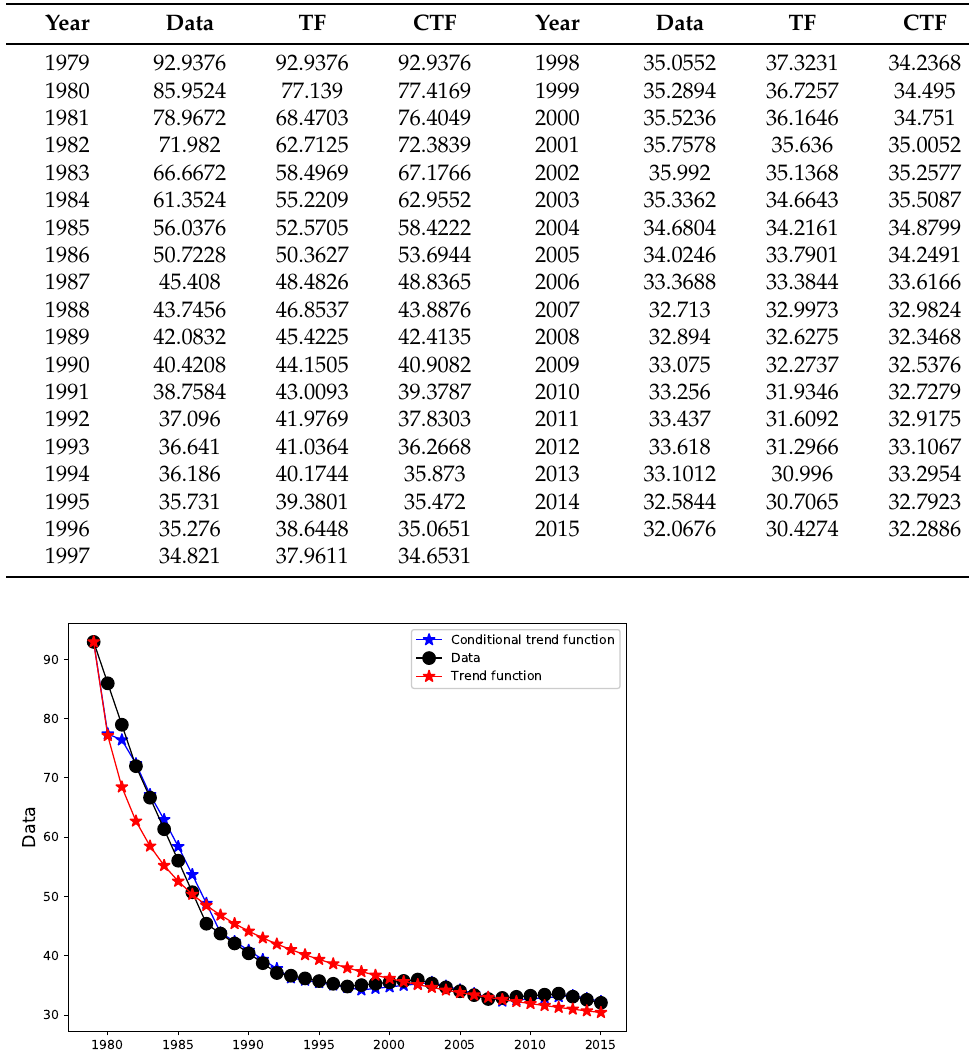
Table 1. Table of adolescent fertility rate data by year.